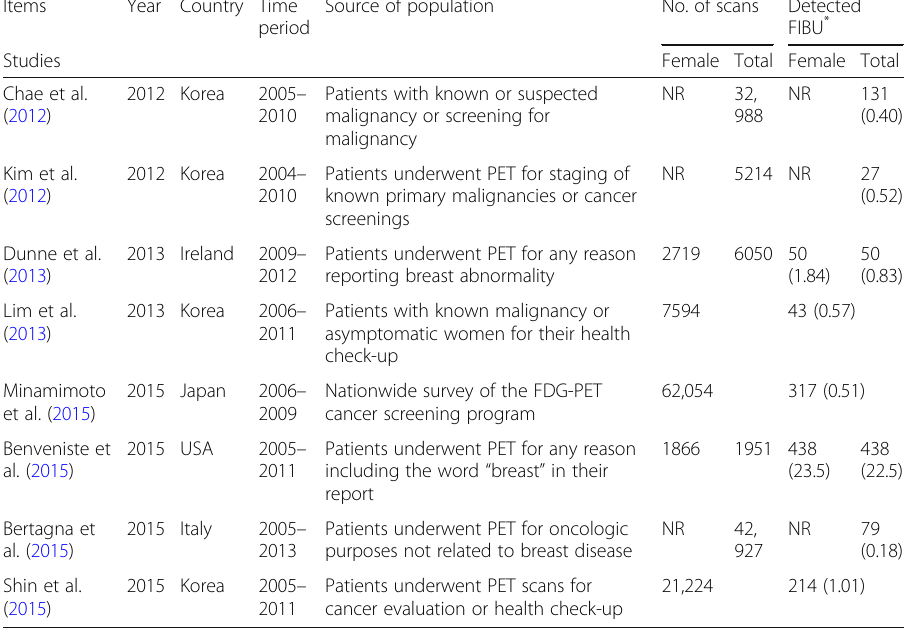
Table 1 Characteristics of included studies and prevalence of FIBU Items Year Country Time Source of period